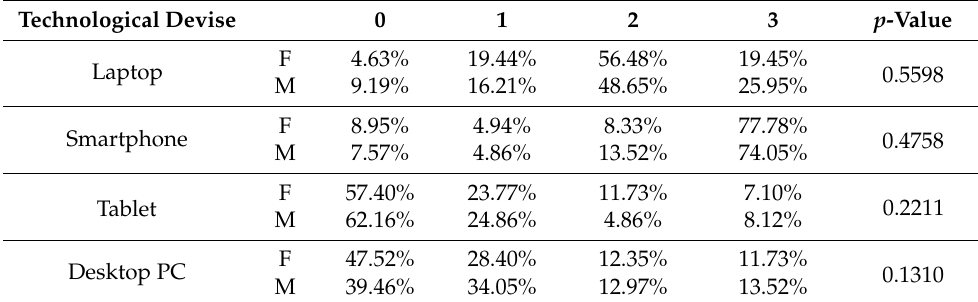
Table 3. Preferred technological device for interaction on the